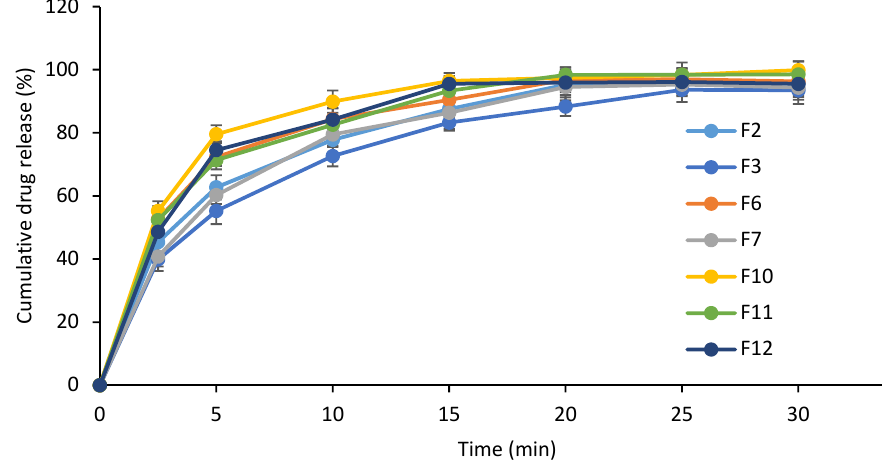
Figure 2. Cumulative in vitro release of DEX from in situ gels of different compositions.